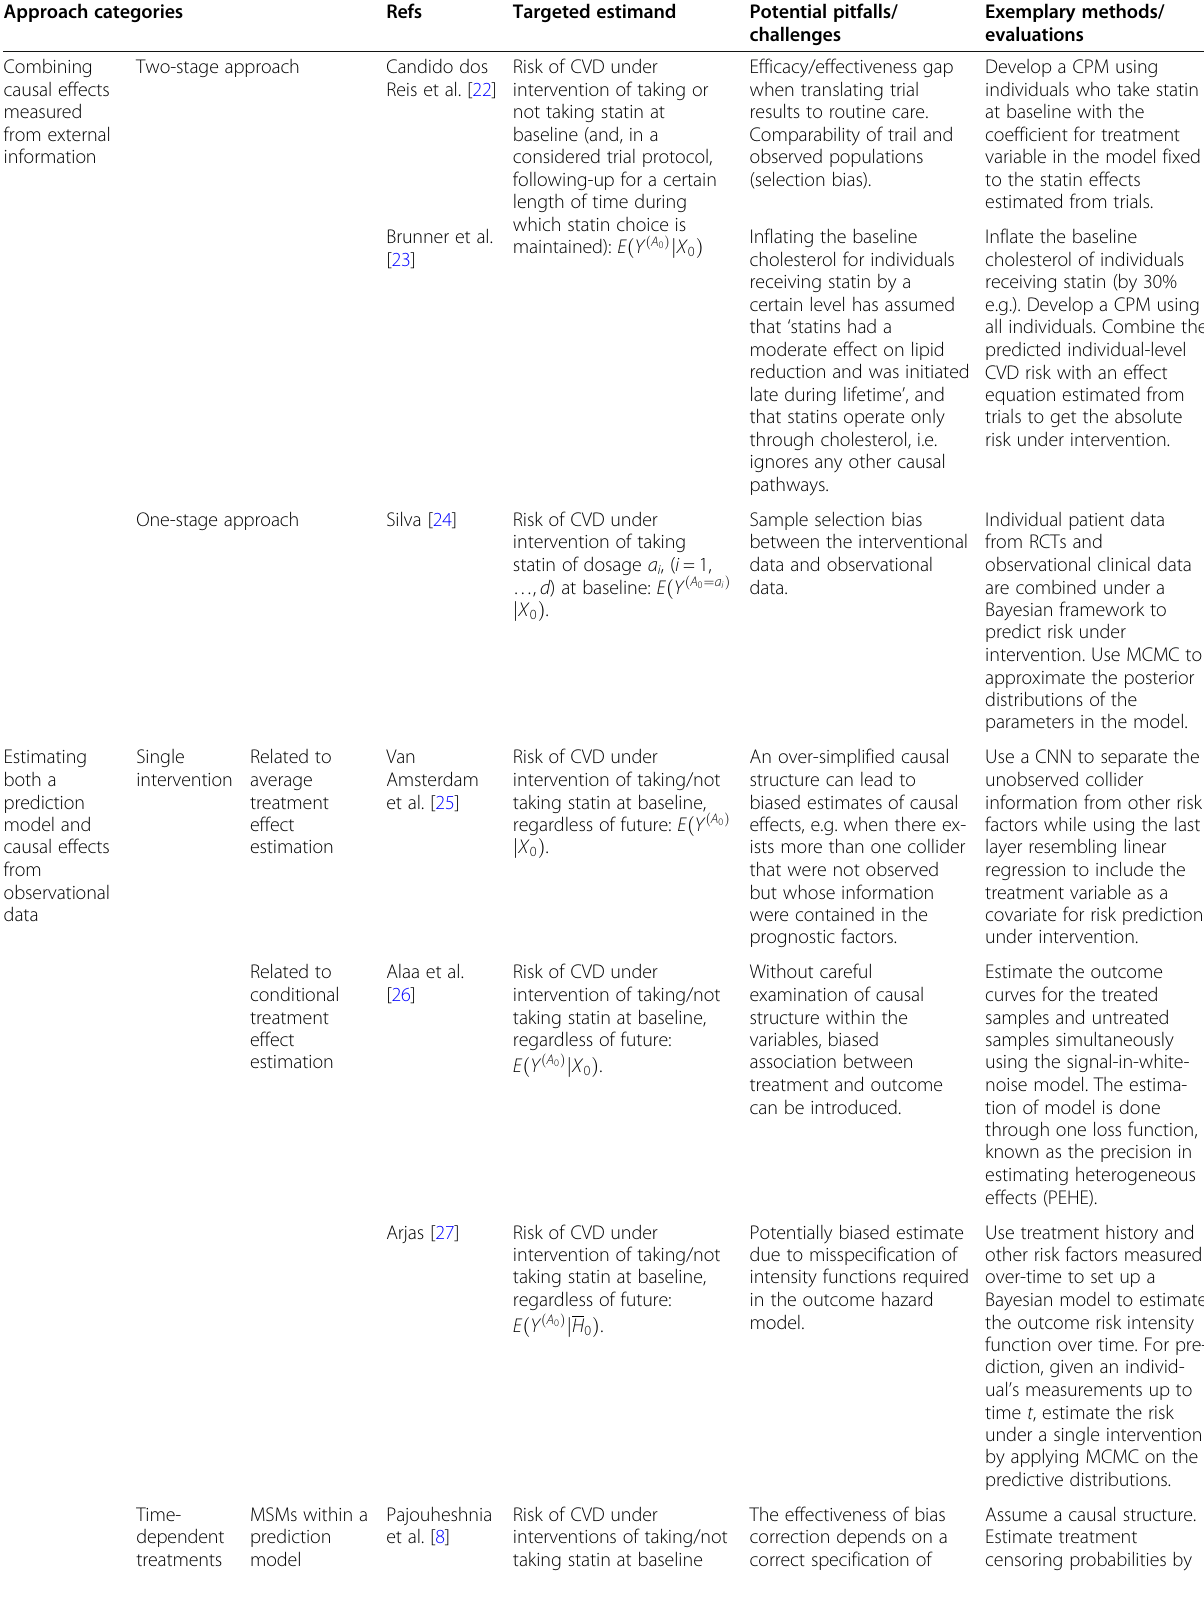
Table 2 Illustration of methods in different categories using an example of statin intervention in primary prevention of CVD Approach